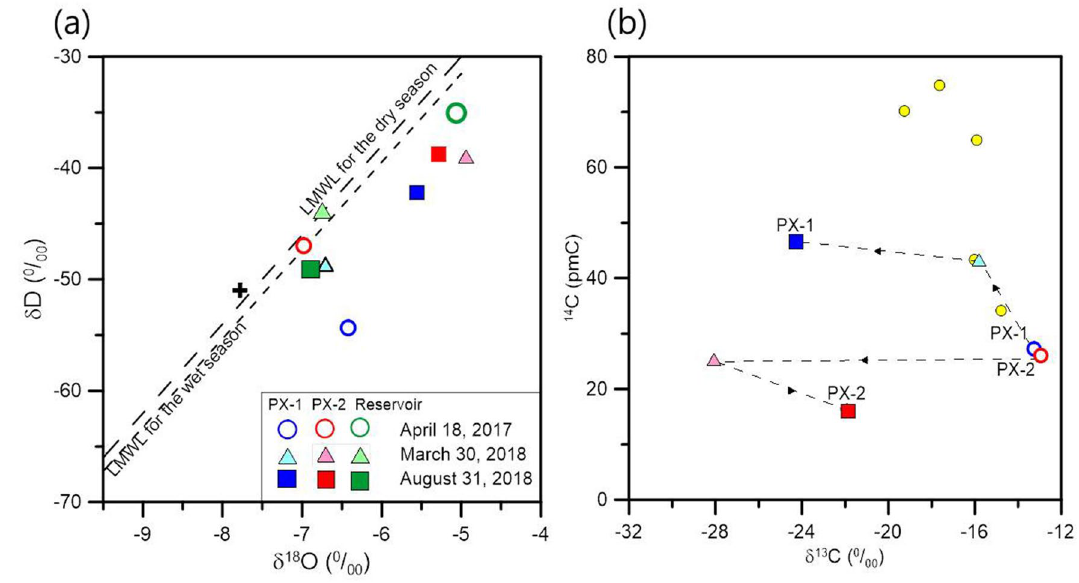
Figure 4. Comparison of the water chemistry of PX-1, PX-2, and reservoir water used as injection water after the M W 3.2 and 5.5 earthquakes in ( a ) δ 18 O and δD; and ( b ) 14 C and δ 13 C; yellow circles indicate samples collected near the Pohang area described in Kaown et al. 21 . The black cross indicates a weighted average of δ 18 O and δD in precipitation data around the Pohang area by Lee and Chung 48